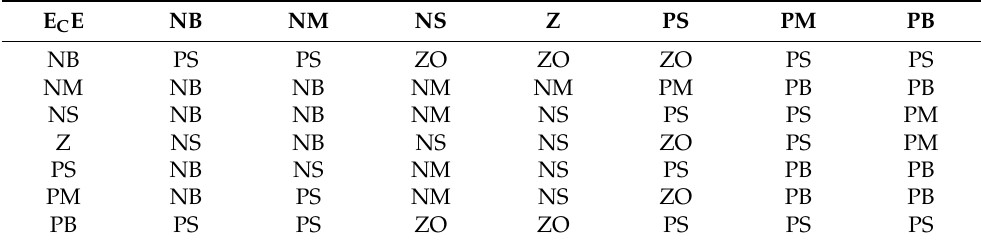
Table 4. Fuzzy control rule for ∆ K d .